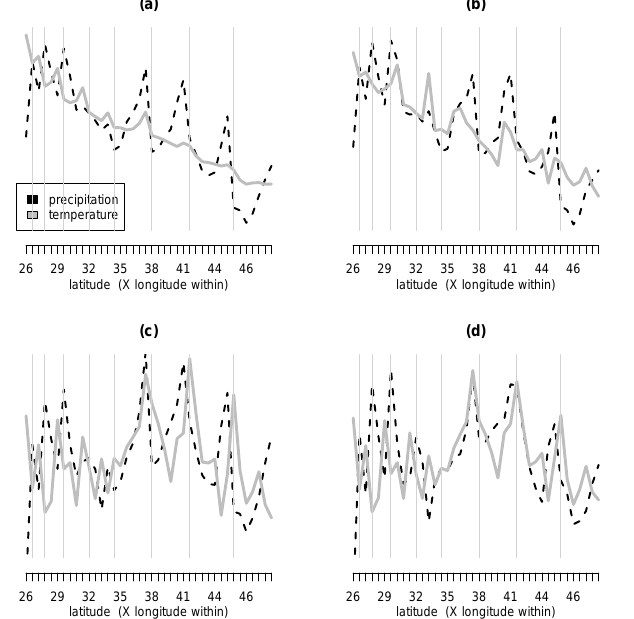
Figure 4. Residuals after mean filtering from observational proxy data (DJF), in eastern North America (ENA): (a) Y ∼ 1, (b) Y ∼ elev, (c) Y ∼ elev + lat, and (d) Y ∼ elev + lat + lon.